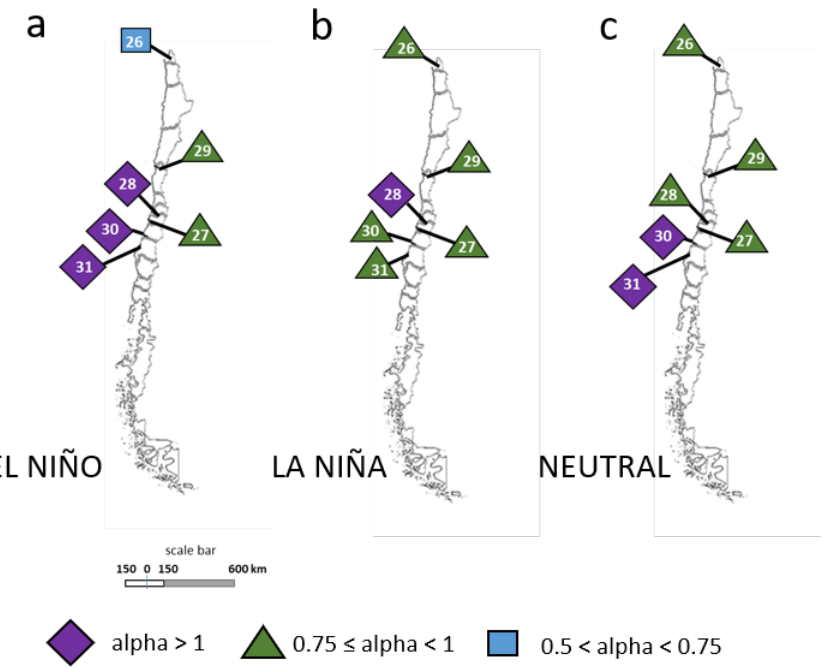
Figure 10. Spatial evaluation of α values for El Niño ( a ), La Niña ( b ), and Neutral ( c ) periods in Chile. La Niña moved the alpha value from sub-diffusive to persistent in the cities Los Despachos and Coronel de Maule, the southernmost analyzed